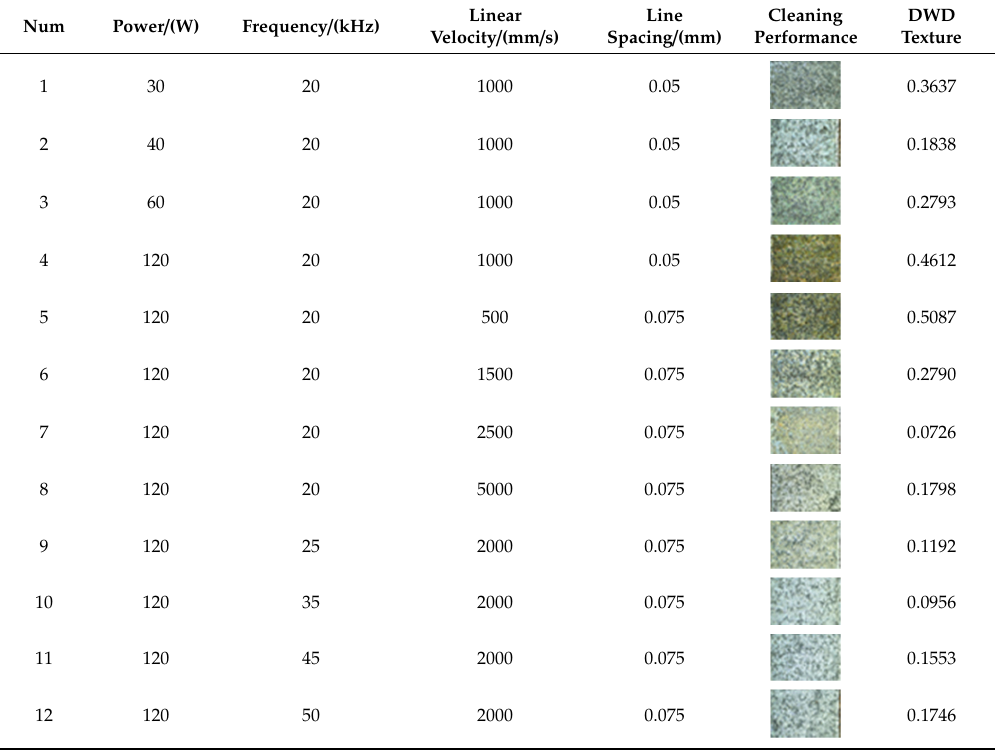
Table 4. The laser cleaning performances using different process parameters.